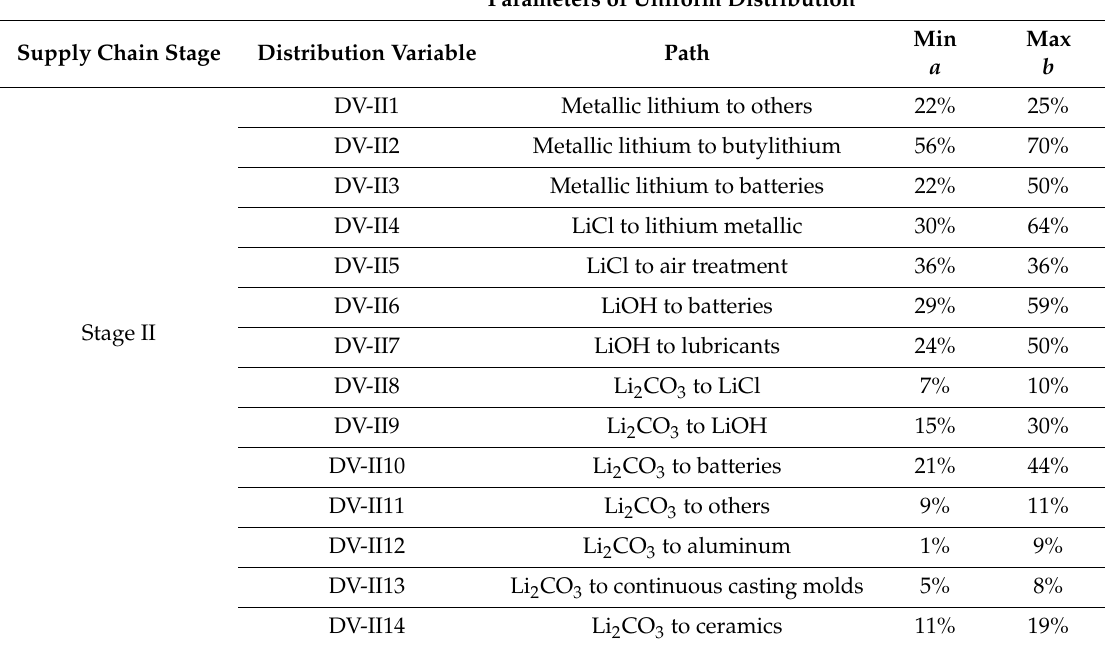
Table 3. Maximum and minimum values for the uniform distribution in the second stage of the supply chain. The paths extend from chemical production to manufacturing.